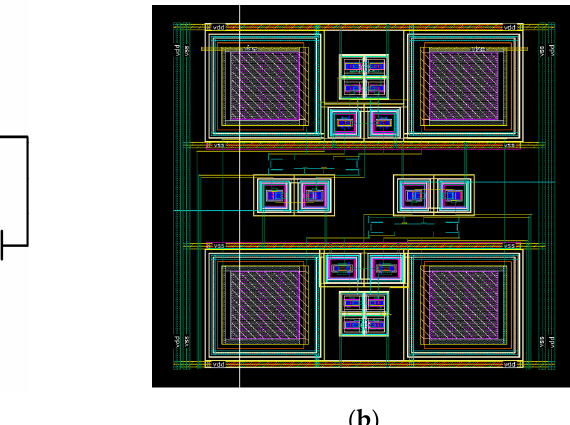
Figure 14. Transfer function (magnitude) of the IF amplifier.